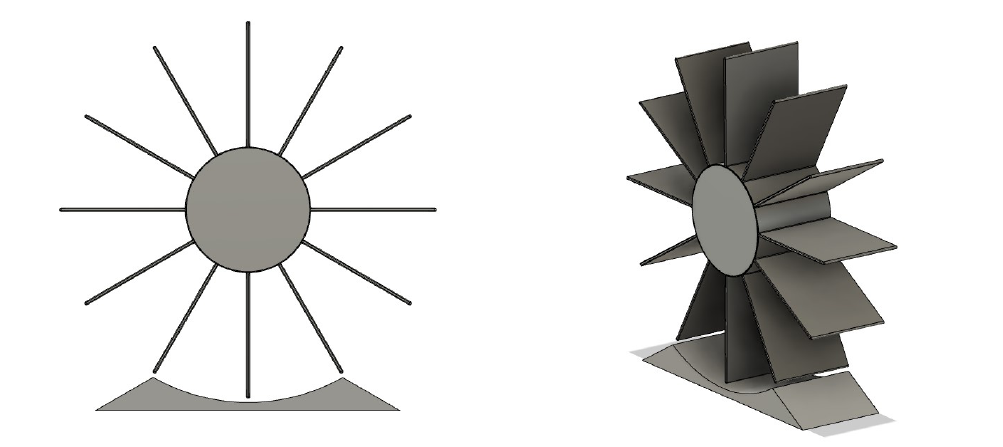
Figure 4. Computational model of the analysed